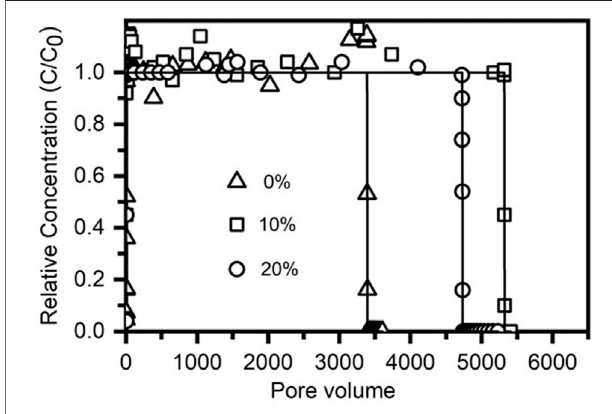
FIGURE 2 | Breakthrough and elution of Br − from sand columns containing 0, 10, and 20% birnessite-coated sand.